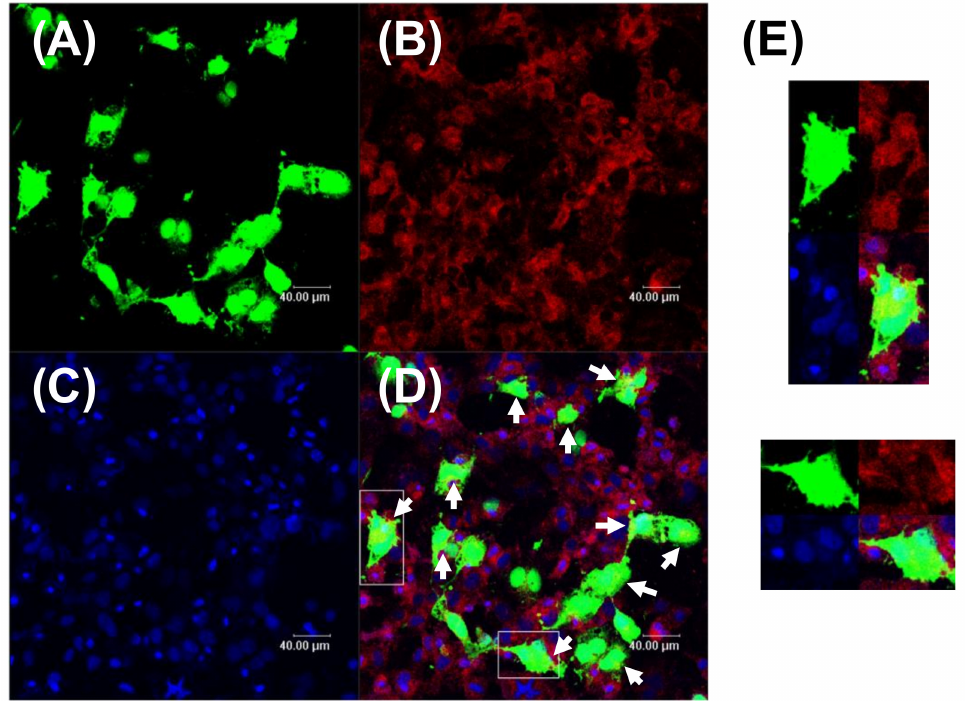
Figure 5. Confocal Laser Scanning Microscope (CLSM) images of MCF-7 cells transfected with DOX-NPs/pEGFP complexes at the optimal w / w ratio of 10. ( A ) Expressed EGFP fluorescence (green); ( B ) DOX fluorescence (red); ( C ) cell nuclei stained by DAPI (blue); ( D ) merged image of (A–C); ( E ) magnifications of the image in the white box. Scale bars in all images represent 40 µ